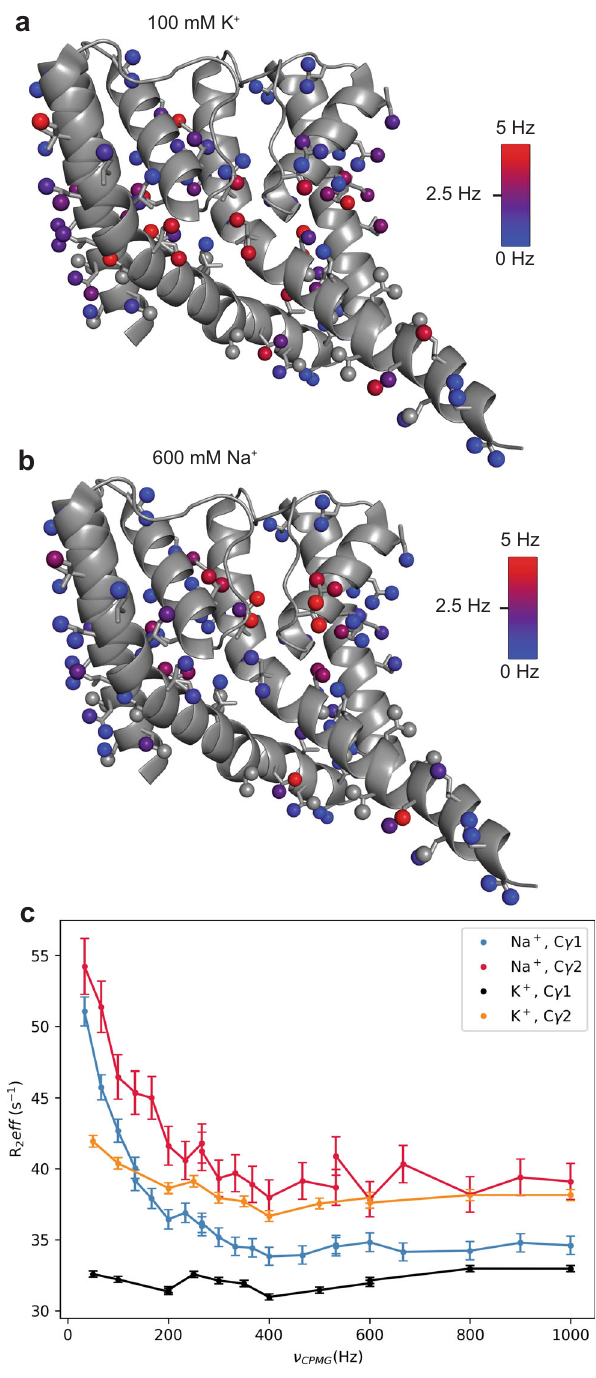
Fig. 6 V64 undergoes enhanced chemical exchange in the presence of Na + . a 13 C Multiple Quantum (MQ) R ex values for ILV labeled NaK in the presence of K + ( a ) and Na + ( b ) are plotted on the structure (3E8H [10.2210/pdb3E8H/pdb]). c 13 C MQ relaxation dispersion curves for V64 in the presence of 100 mM K + and 600 mM Na + . Error bars represent the SD from three replicated data